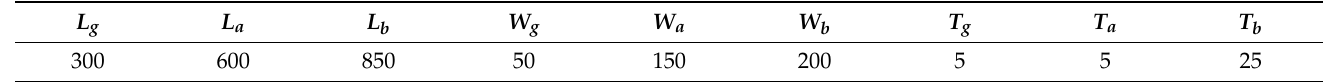
Table 2. Size data of model (unit: µm).